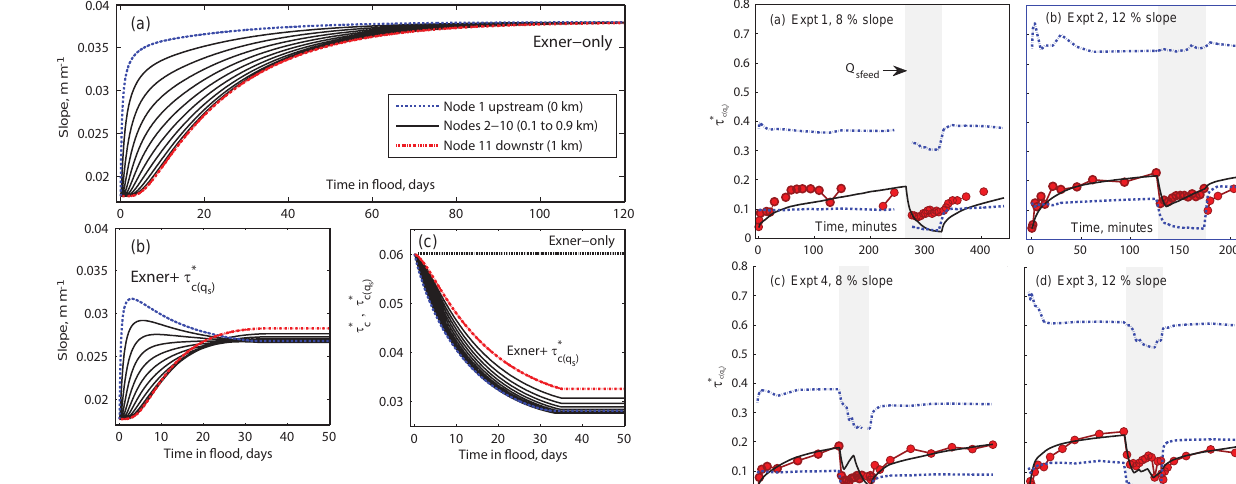
Figure 9. Spatial and temporal evolution of morphodynamic slopes, for the same models shown in Fig. 6. Slope is initially at equilibrium and responds to the 5 × increase in upstream sediment supply at t = 0. (a) The Exner-only model initially has spatial slope variability, but evolves to a uniform new equilibrium slope. (b, c) In the Exner + τ ∗ model, spatial variability in both slope and τ ∗ c( q s ) persist even at equilibrium.